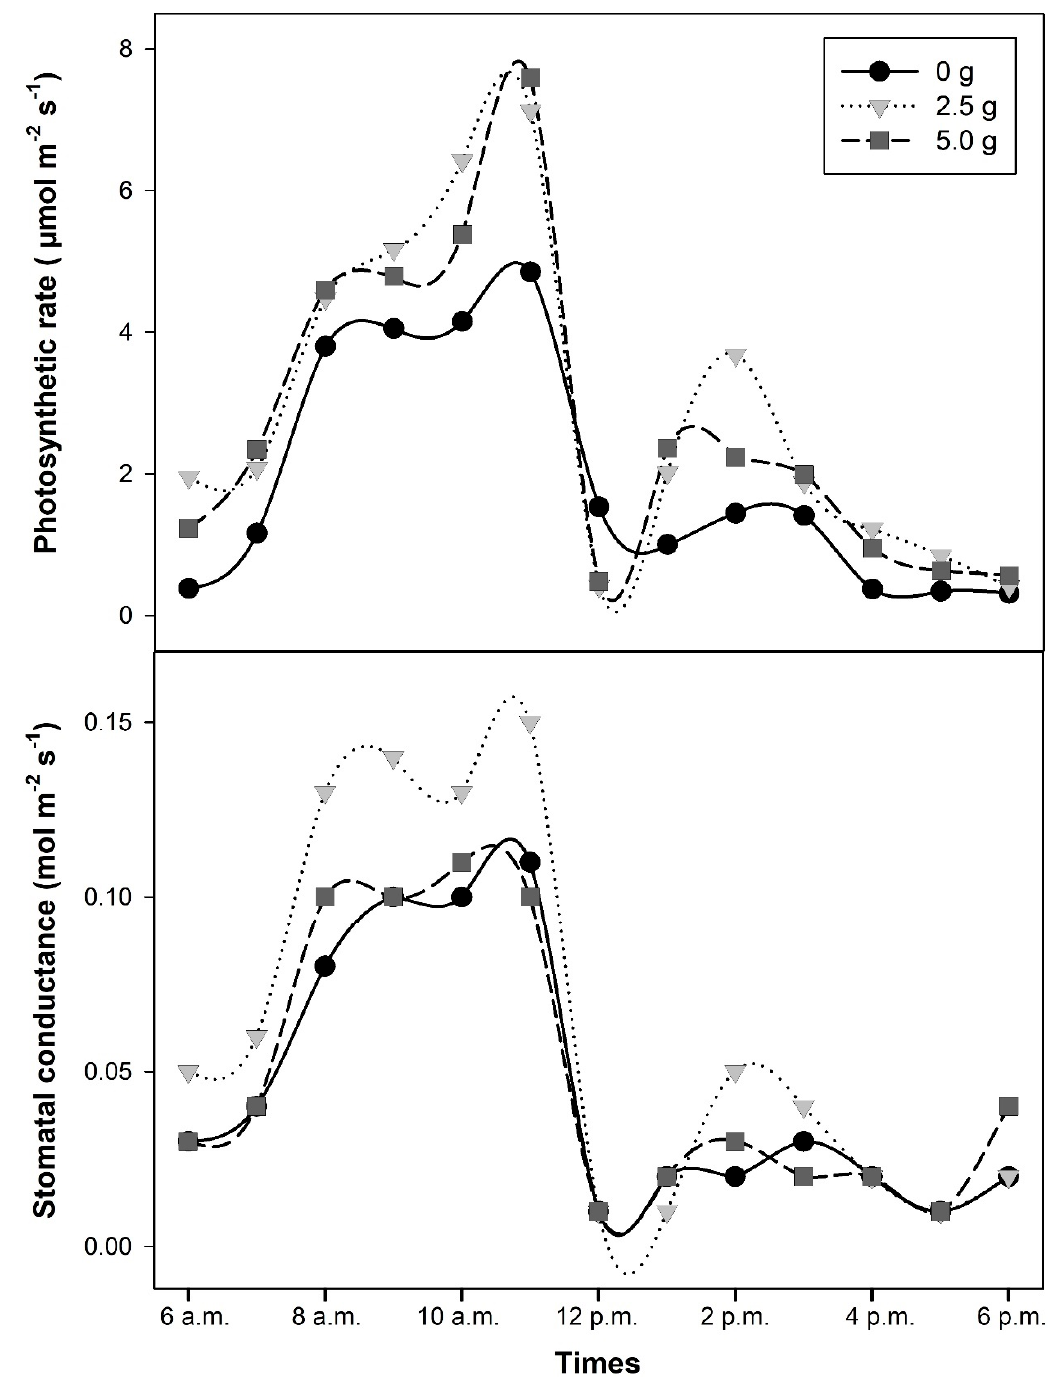
Figure 3. Diurnal photosynthetic rates (µmol m − 2 s − 1 ) and stomatal conductance (mol m − 2 s − 1 ) of Hippeastrum ‘Red Lion’ grown under different fertilization rates 90 days after planting.